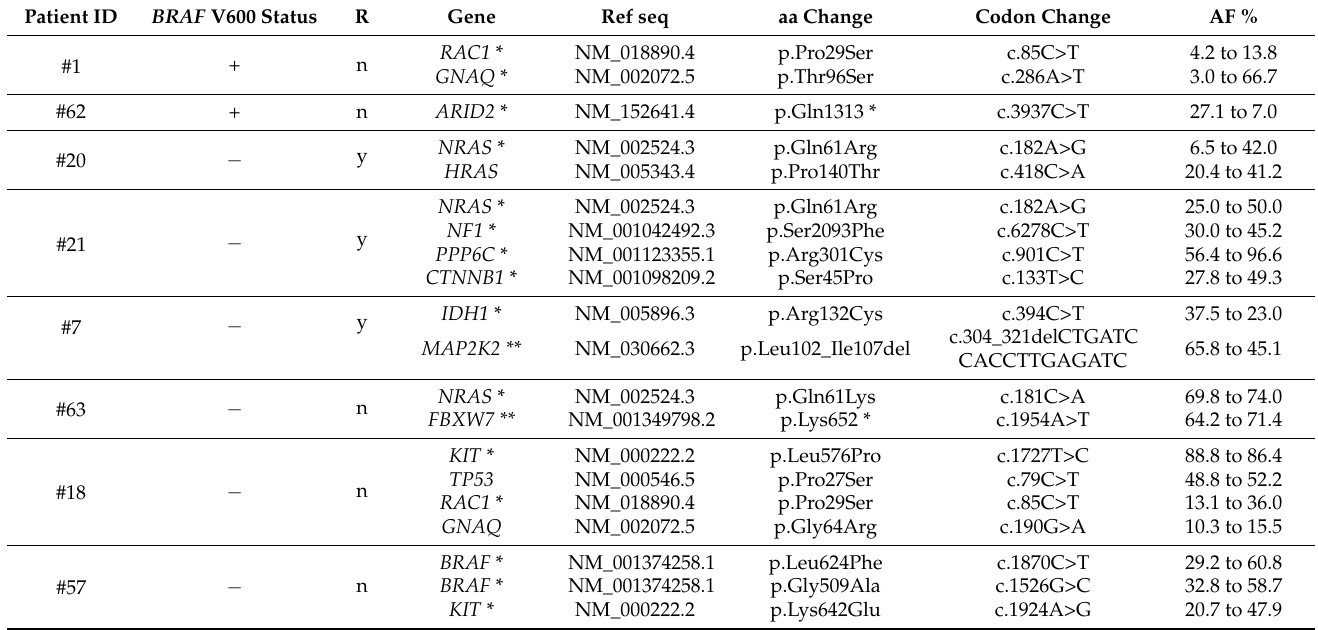
Table 1. Melanoma driver gene variants detected by Whole-Exome Sequencing (WES) in common between pre-therapy and post-therapy melanoma lesions.